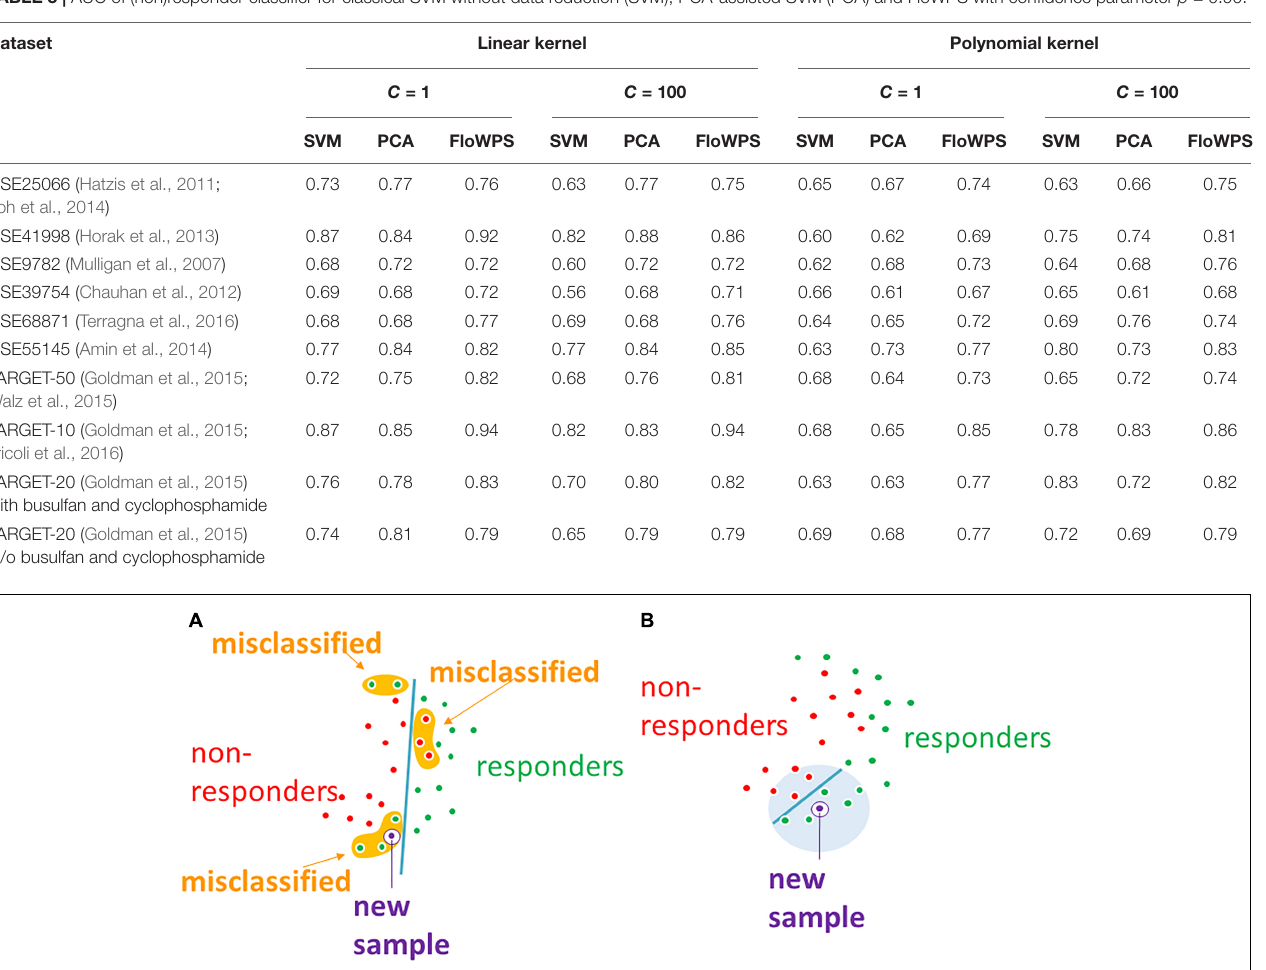
FIGURE 6 | (A) Global machine learning methods, such as SVM, may fail to separate classes in datasets without global order. (B) Machine-learning with data trimming works locally and may separate classes more